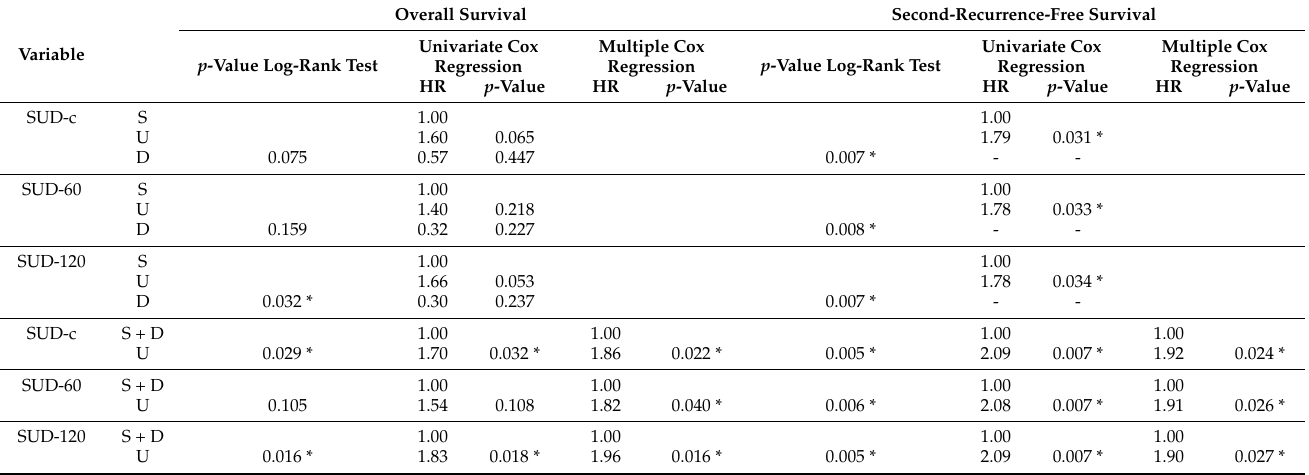
Table 3. Log-rank test, along with univariate and bivariate Cox regression analyses, for over- all survival, second-recurrence-free survival, and disease-specific survival on SUD; * denotes a p -value < 0.05. Acronyms: SUD-c = SUD on complete follow-up; SUD60 = SUD on follow-up of 60 months; SUD120 = SUD on follow up of 120 months; S = same-stage; U = up-stage; D =